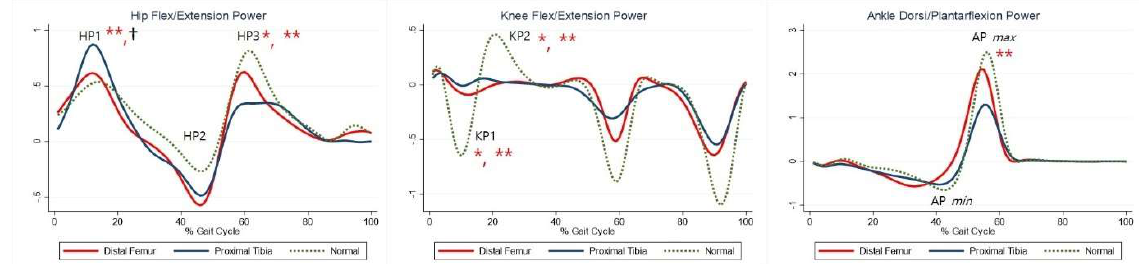
Figure 4. Powers for each group. The red lines represent mean values for the distal femur group. The blue lines represent mean values for the proximal tibia group. The dashed lines represent the healthy subjects. * Statistically significant for the comparison between distal femur group and healthy subjects. ** Statistically significant for the comparison between proximal tibia group and healthy subjects. † Statistically significant for the comparison between distal femur group and proximal tibia group.